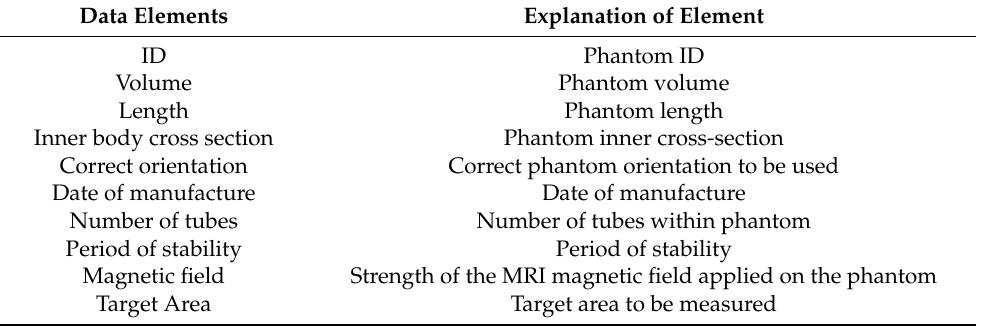
Table 3. Phantom Data Model Elements and Explanation.